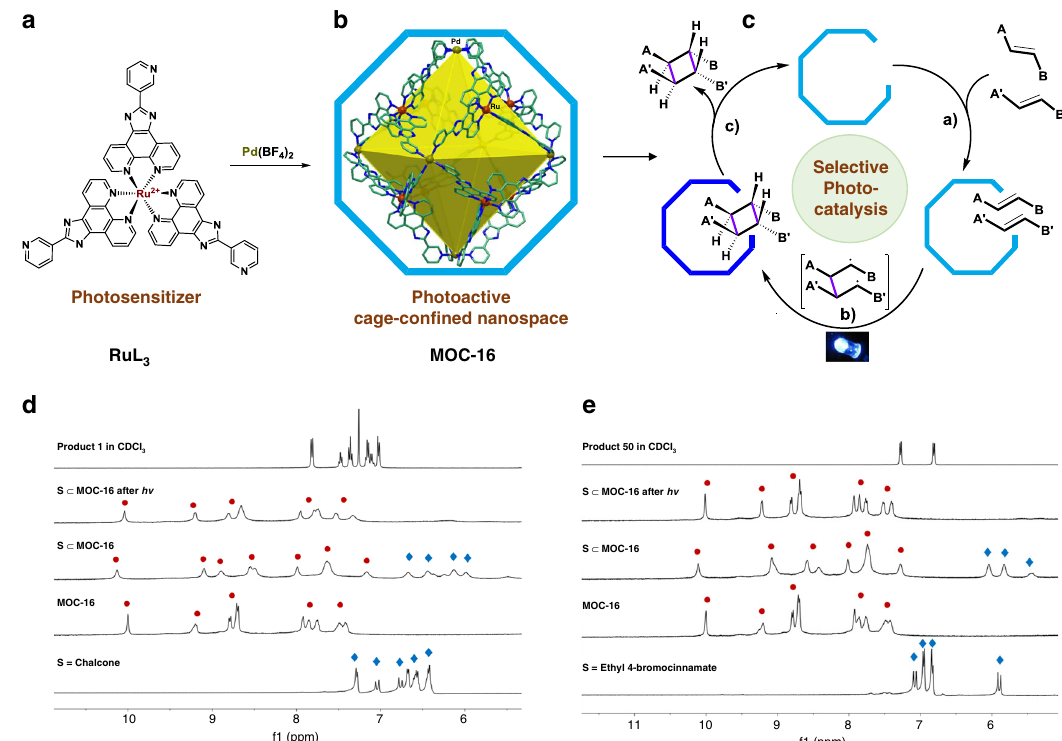
Fig. 1 Photoactive supramolecular nanoreactor for cage-con fi ned catalysis. a , b Assembly of nanosized [Pd 6 (RuL 3 ) 8 ] 28 + MOC-16 with octahedral cavity organized from RuL 3 (BF 4 ) 2 photosensitizers. c Auto-recycled catalytic process enabling visible-light-induced selective [2 + 2] cycloaddition in a cage- con fi ned nanospace to generate syn -HH diasteroisomer through: a) encapsulation and pre-orientation of ole fi ns, b) preferable [2 + 2] cycloaddition via ef fi cient triplet energy-transfer, and c) release of cyclobutane product due to host-guest inadaptation. d 1 H NMR trace of chalcone photocycloaddition, showing substrate inclusion by MOC-16 (400 MHz, DMSO- d 6 -D 2 O, v-v = 1:3, 298 K), recovery of MOC-16 after product precipitation along LED irradiation, and formation of product 1 . e 1 H NMR monitoring of ethyl 4-bromocinnamate photocycloaddition process to form product 50 . Photoproducts are insoluble in mixed DMSO- d 6 -D 2 O solvent and measured in CDCl 3